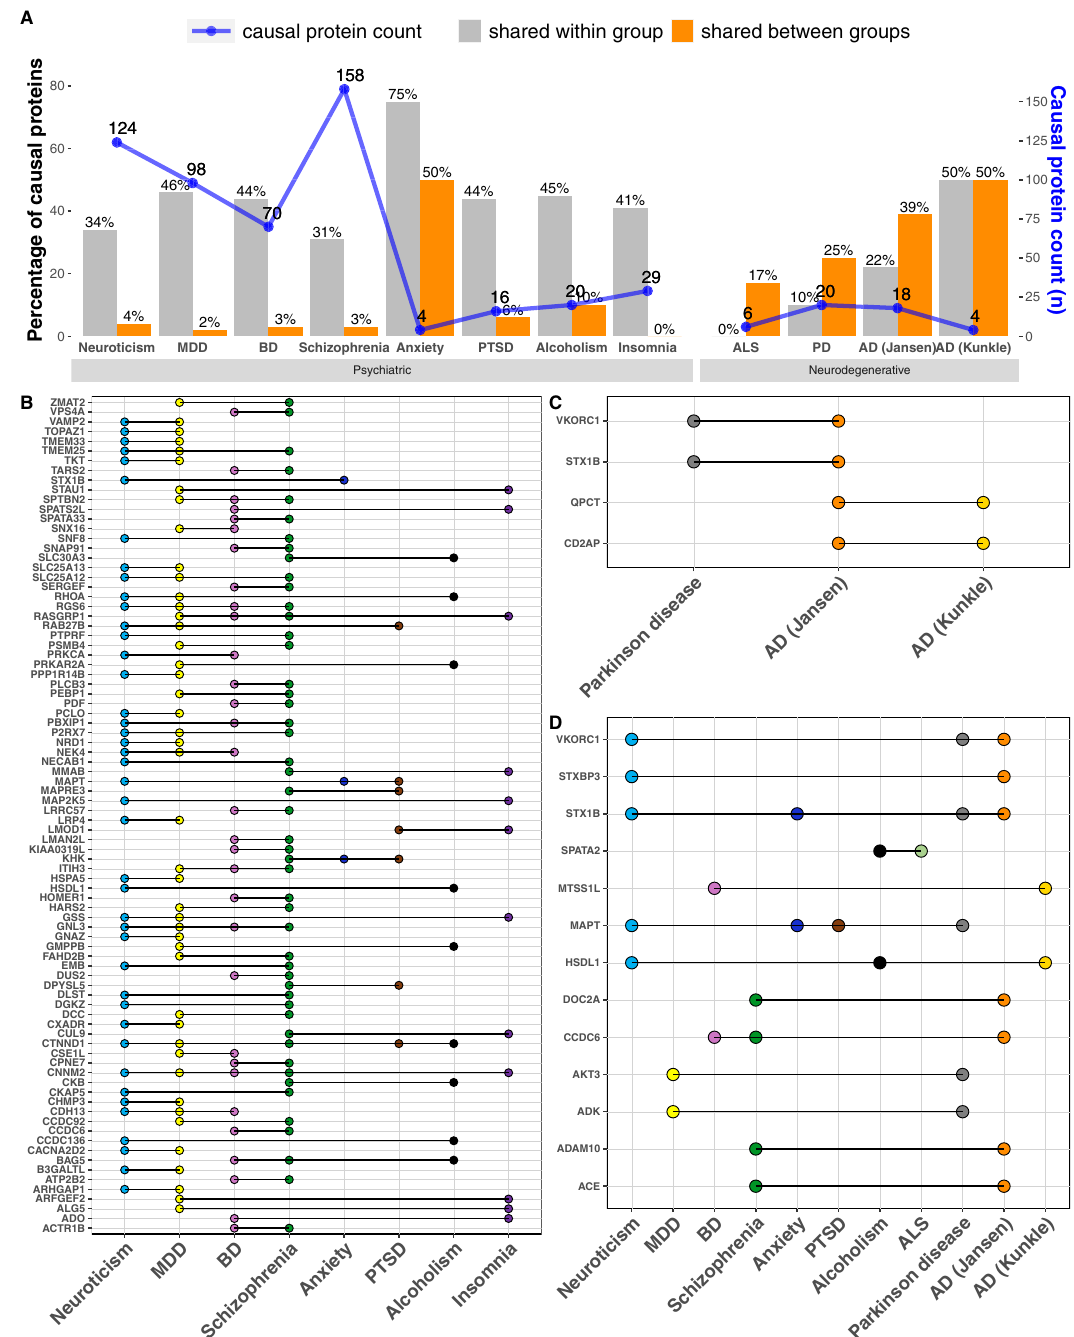
Fig. 3 | Causal brain proteins sharedwithin and between groups of psychiatric andneurodegenerativediseases.A Numberofcausalproteinsandpercentshared within group and between groups of psychiatric and neurodegenerative diseases. B Causal proteins shared within the psychiatric group. C Causal proteins shared